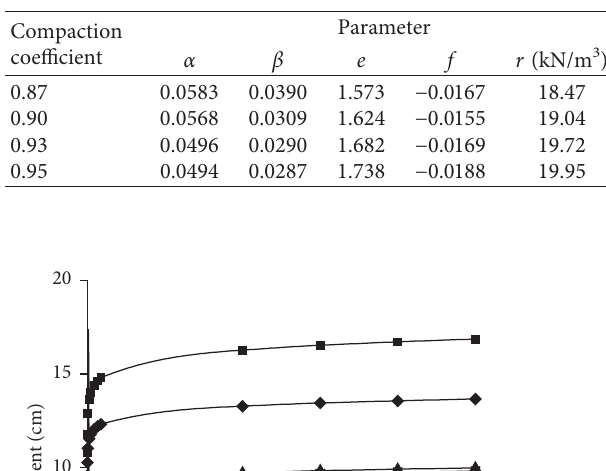
Table 4: Empirical equation parameters of different compaction